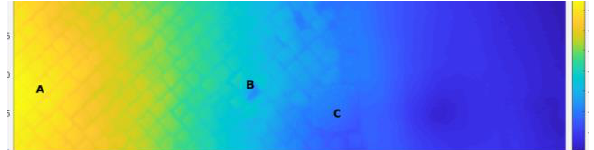
Figure 5. OpenCRG model of a road segment. Note that the cobblestones (A), pothole (B) and manhole (C) can be recognized